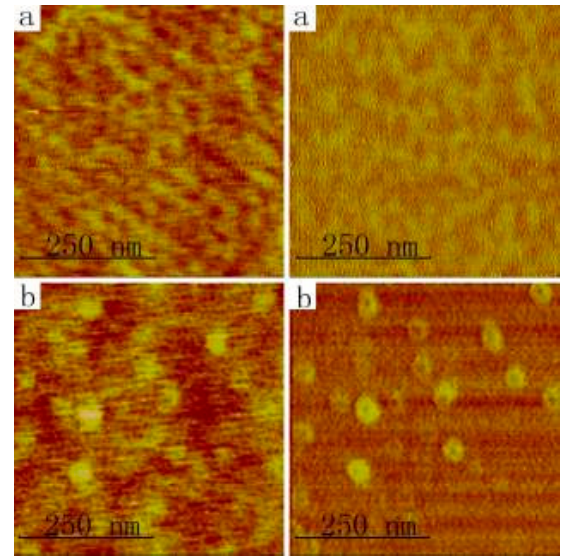
Figure 6. Atomic force microscopy (AFM) images showing height ( left ) and phase ( right ) maps of ( a ) PU-Si0 and ( b ) PU-Si17.